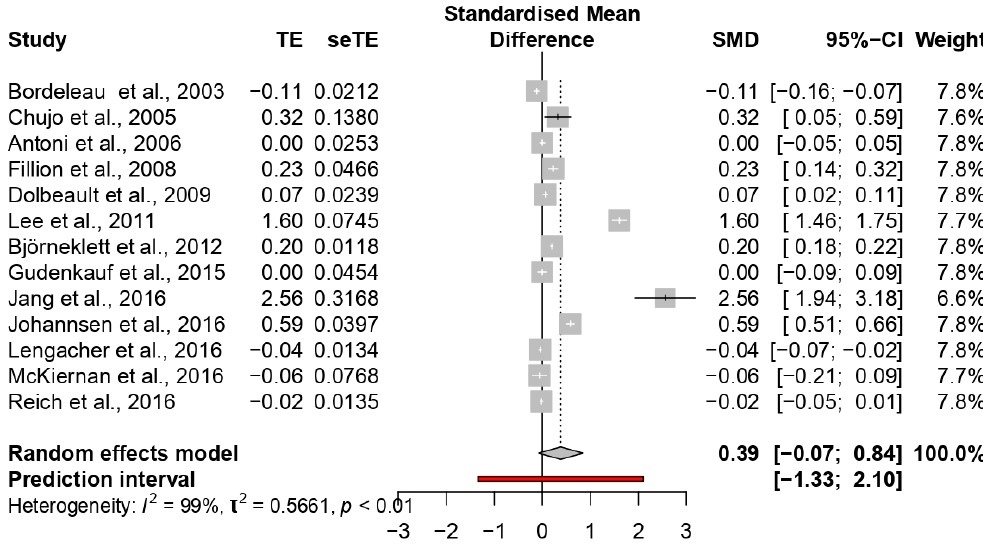
Figure 6. Forest plot of the studies considering psychological interventions focused on increasing quality of life.